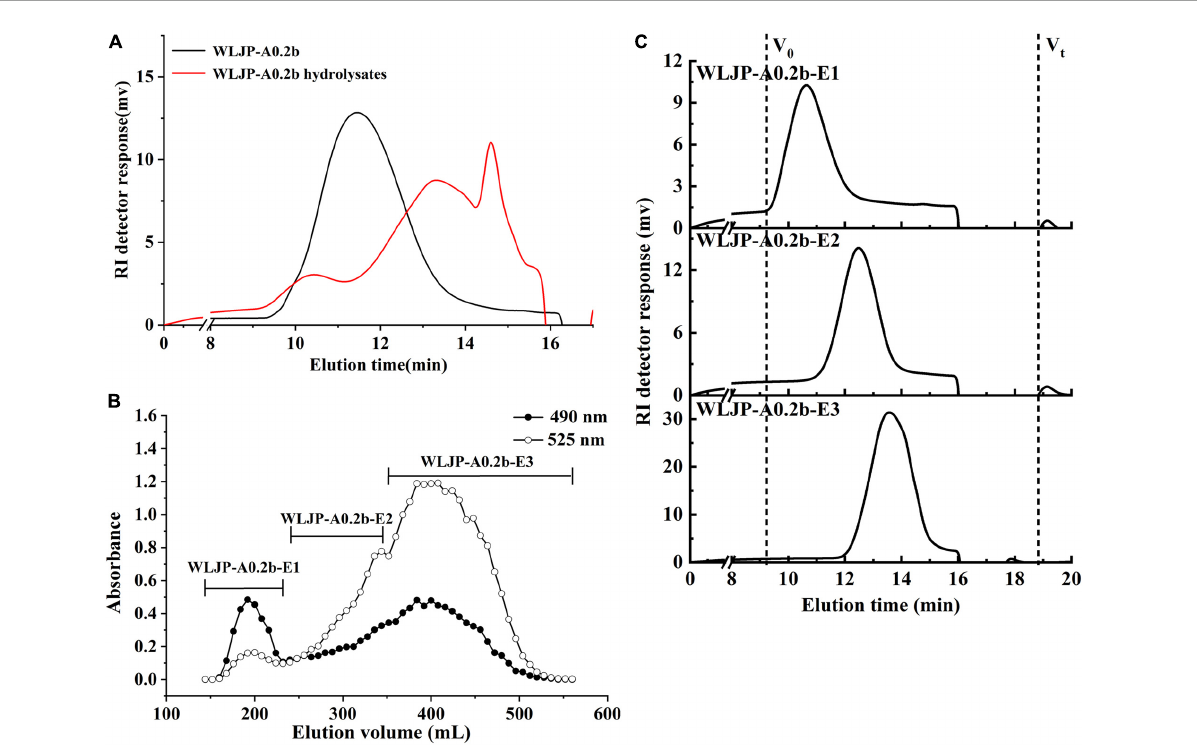
FIGURE3 (A) The molecular weight distributions of WLJP-A0.2b before and after endo-polygalacturonanase (Endo-PG) hydrolysis. (B) The elution profile of enzymatic hydrolysis product of WLJP-A0.2b on Sephadex G-75 (- gel-permeation chromatography (HPGPC) elution profiles of three sub-fractions of